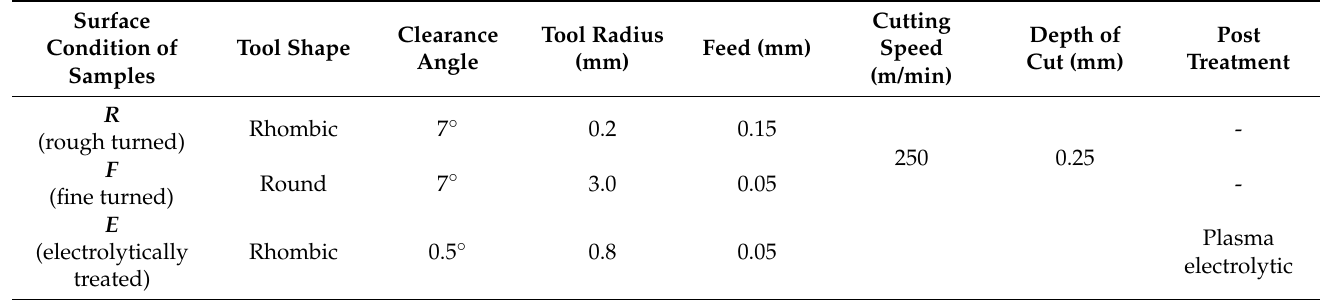
Table 1. Generation of various surface conditions by machining and post-treatment before pin-on- disc